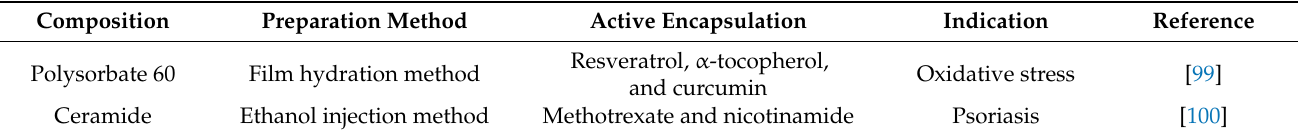
Table 5. Examples of niosomes and the diseases that can benefit from co-encapsulated molecules. Composition Preparation Method Polysorbate 60 Ceramide Ethanol injection